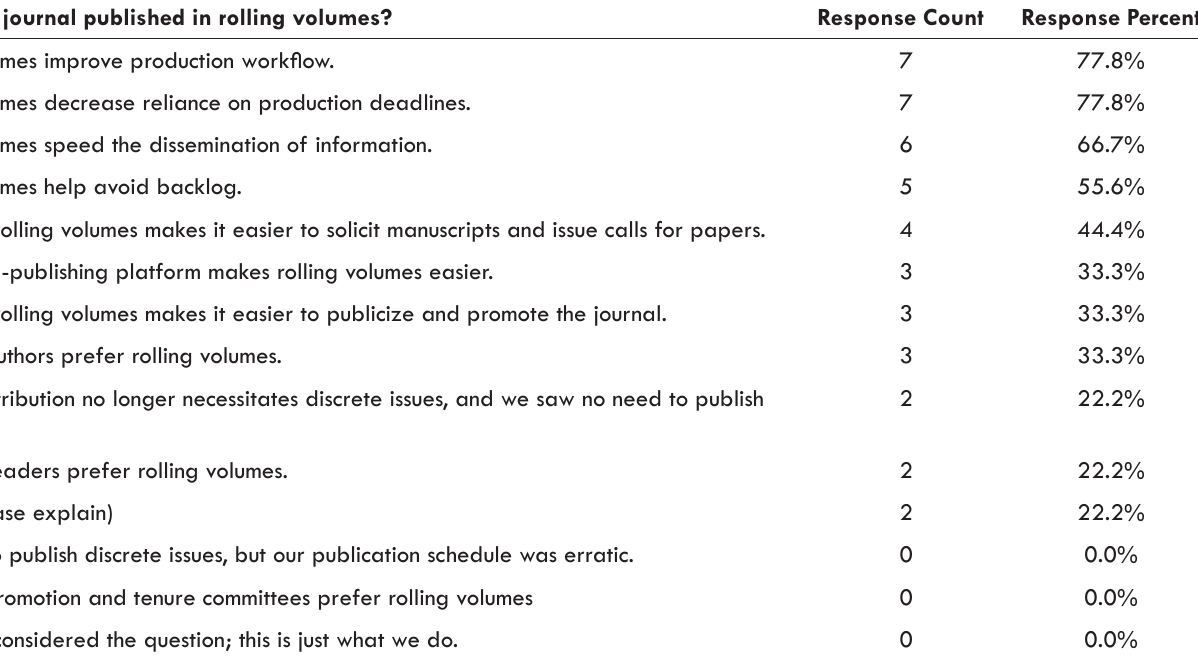
Table 2. Reported reasons for publishing in rolling volumes Why is the journal published in rolling